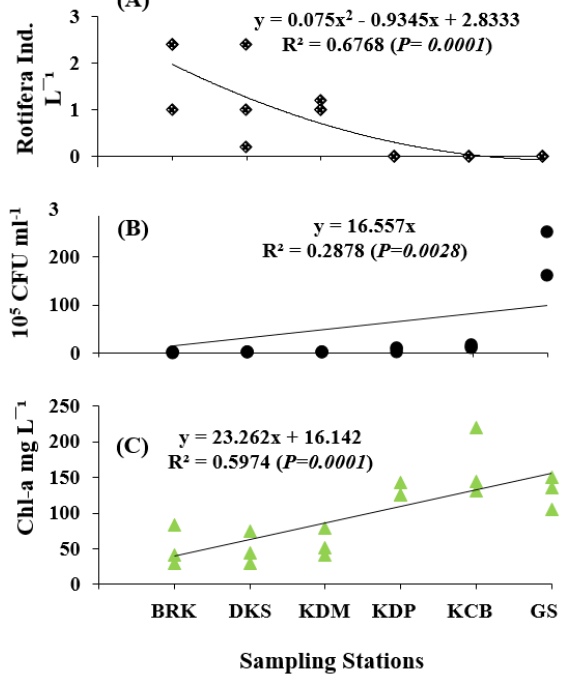
Figure 3. Seaward trends of selected biological parameters estimated for the present study at six sampling sites (Table 1) during October 2017, February 2018, and June 2018 including ( A ) Rotifera, ( B ) bacterial density, and ( C ) chlorophyll- a .